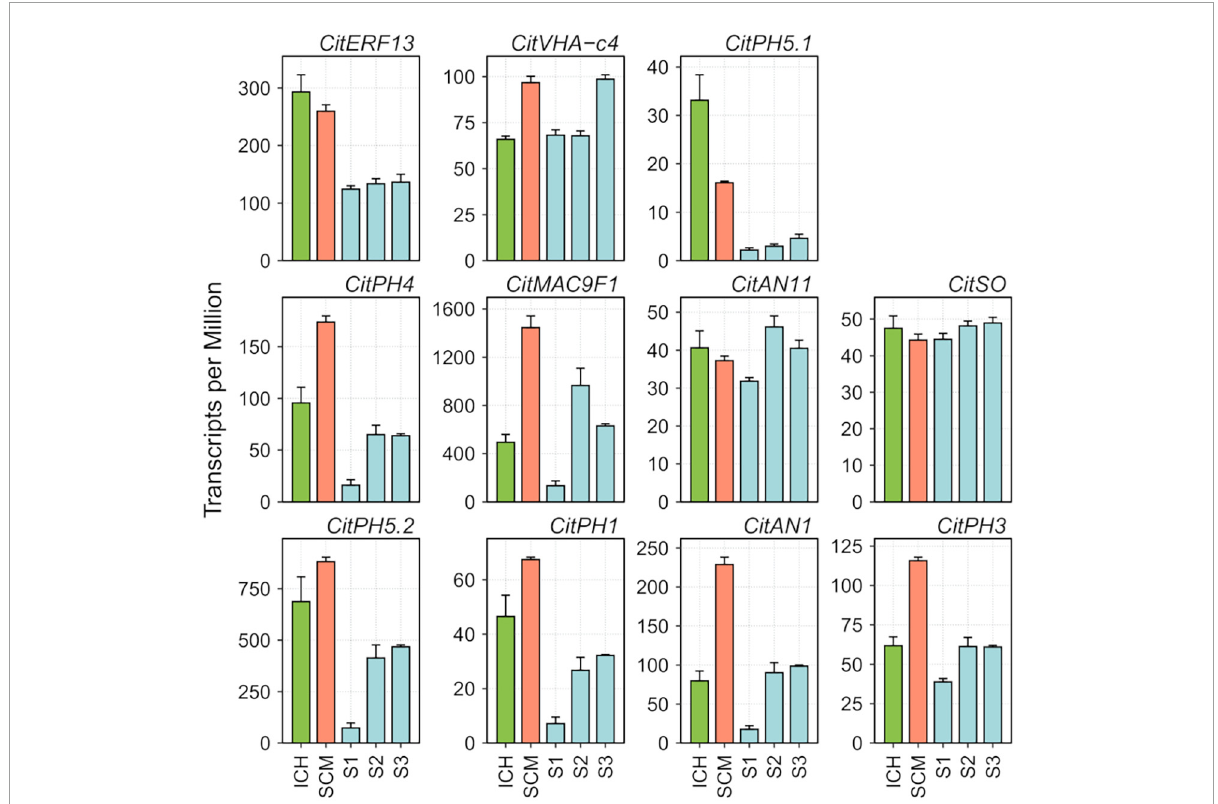
FIGURE2 RNA abundance of relevant genes reported to be involved in acid regulation of citrus fruits (Aprile et al., 2011; Butelli et al., 2019; Strazzer et al., 2019; Huang et al., 2021), obtained in RNA-seq analyses of the pulp of developing fruitlets of ICH, SCM, and S1, S2, and S3 segregants. Transcripts per Million were computed using DESeq2 read count normalization. Vertical bars represent standard error from three biological